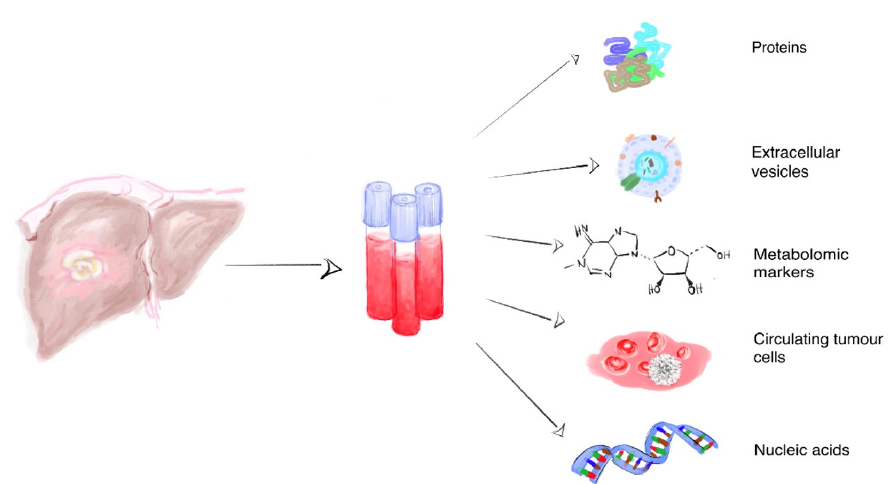
Figure 1. Liquid biopsy in HCC. Various forms of liquid biopsy, aiming at different tumor tracers, have been investigated in HCC. Some are still not commercially available or approved for HCC, or are still under experimental research, including cell-free DNA and cell-free RNA (cfDNA and cfRNA, respectively), circulating tumor cells (CTCs), extracellular vesicles (EVs), and metabolomics.